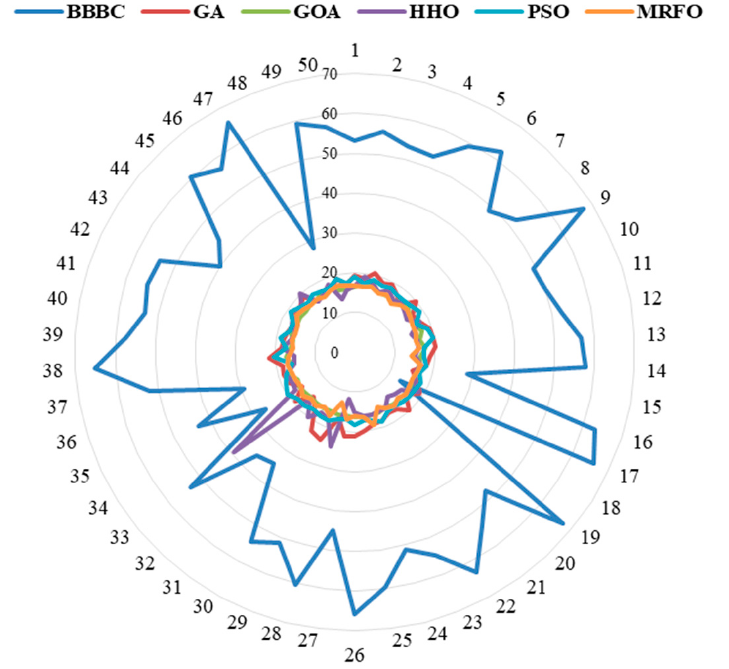
Figure 13. SE vs. runs using MRFO compared to the other five soft computing algorithms for LPSP = 0%.